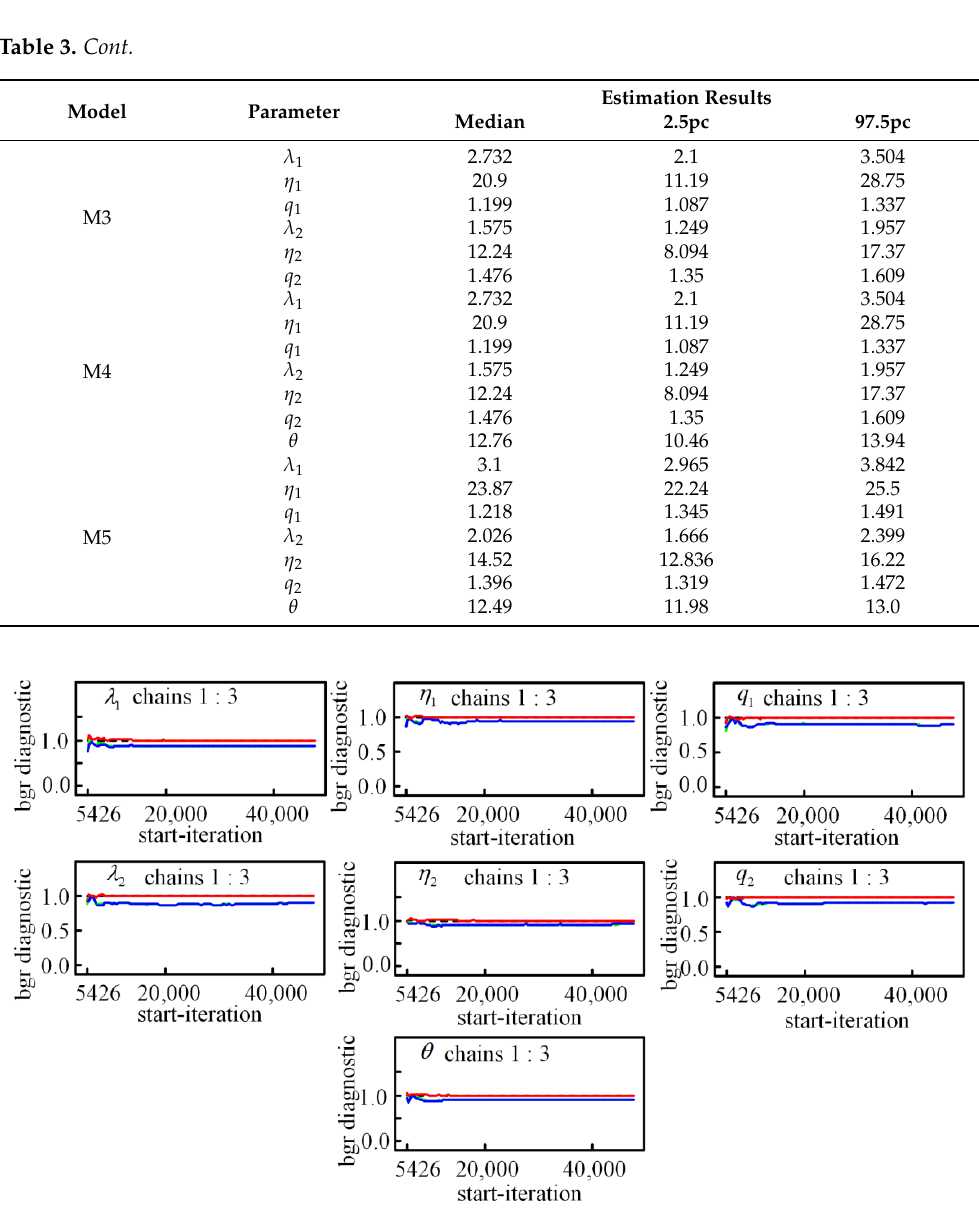
Figure 3. BGR convergence results for parameters in Model 5.